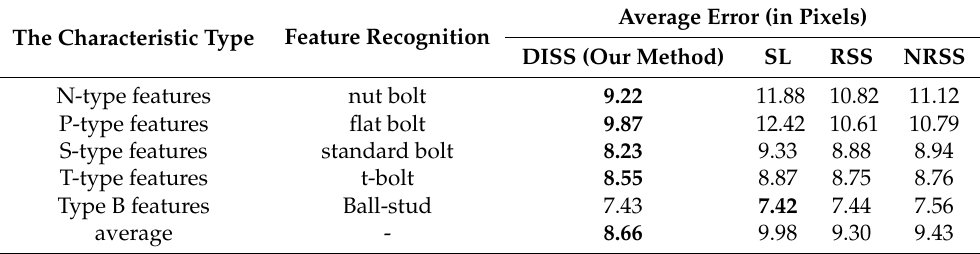
Table 2. The average error of the proposed method and the three benchmark methods on five complex features in Experiment 1.